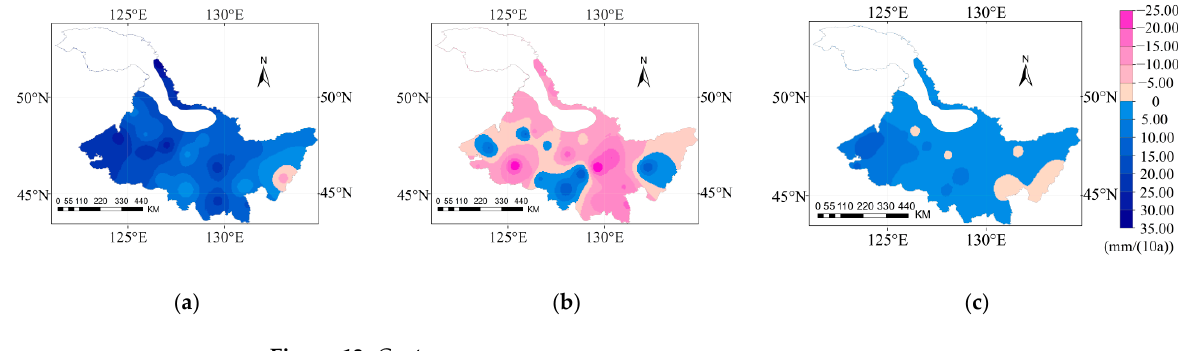
Figure 12. Spatial distribution of irrigation water requirement ( I r ) during the ( a ) 2030s, ( b ) 2050s, and ( c ) 2070s under RCP4.5, and during the ( d ) 2030s, ( e ) 2050s, and ( f ) 2070s under RCP8.5 during the soybean growth period.